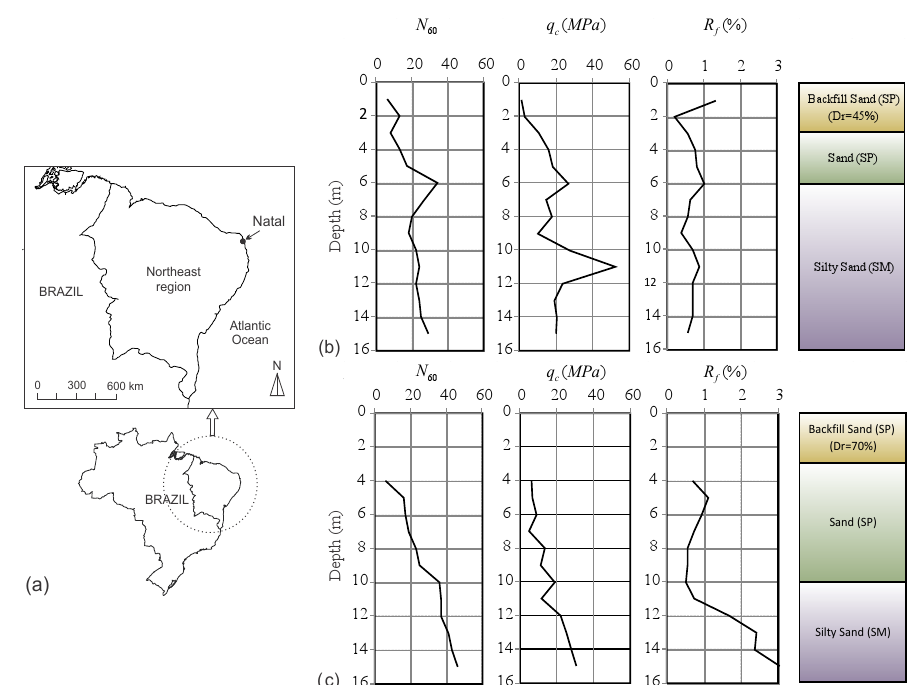
Figure 1. (a) Location of test site; (b) Site investigation results in Area A; (c) Site investigation results in Area